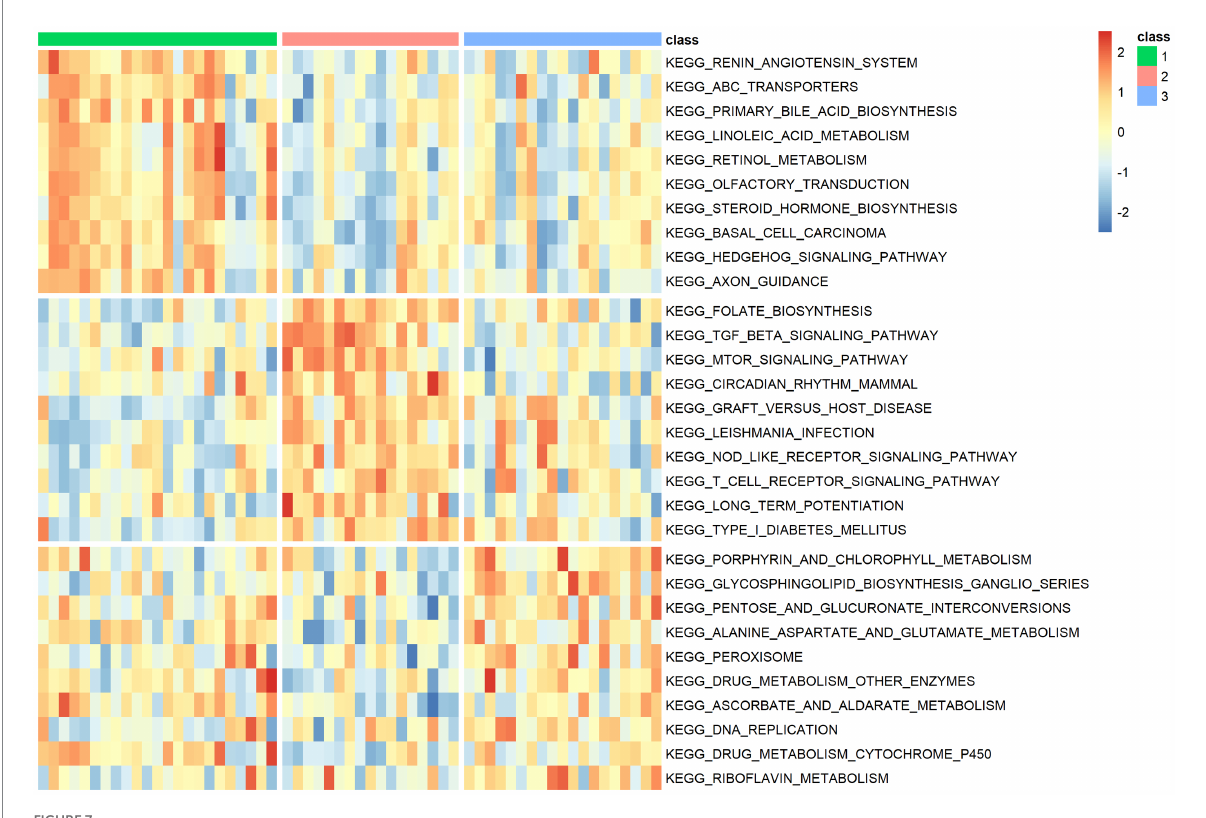
FIGURE 7 Venn diagram of differentially expressed genes between m6A modification